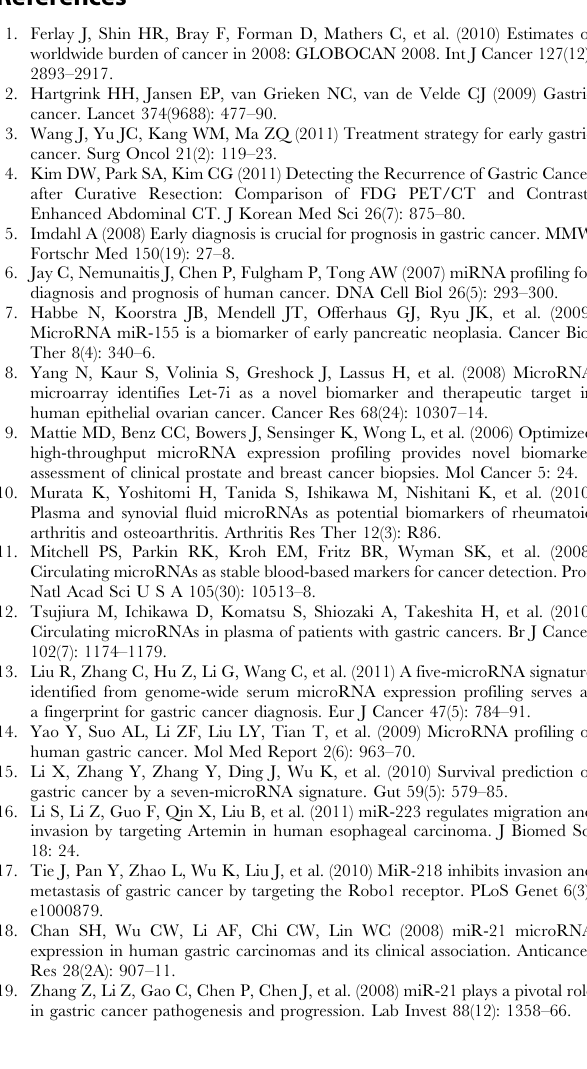
Table S1 The mature microRNAs and their matched primer/probe AB assay ID. Table S2 The concentration values of the four miRNAs measured in the plasma of